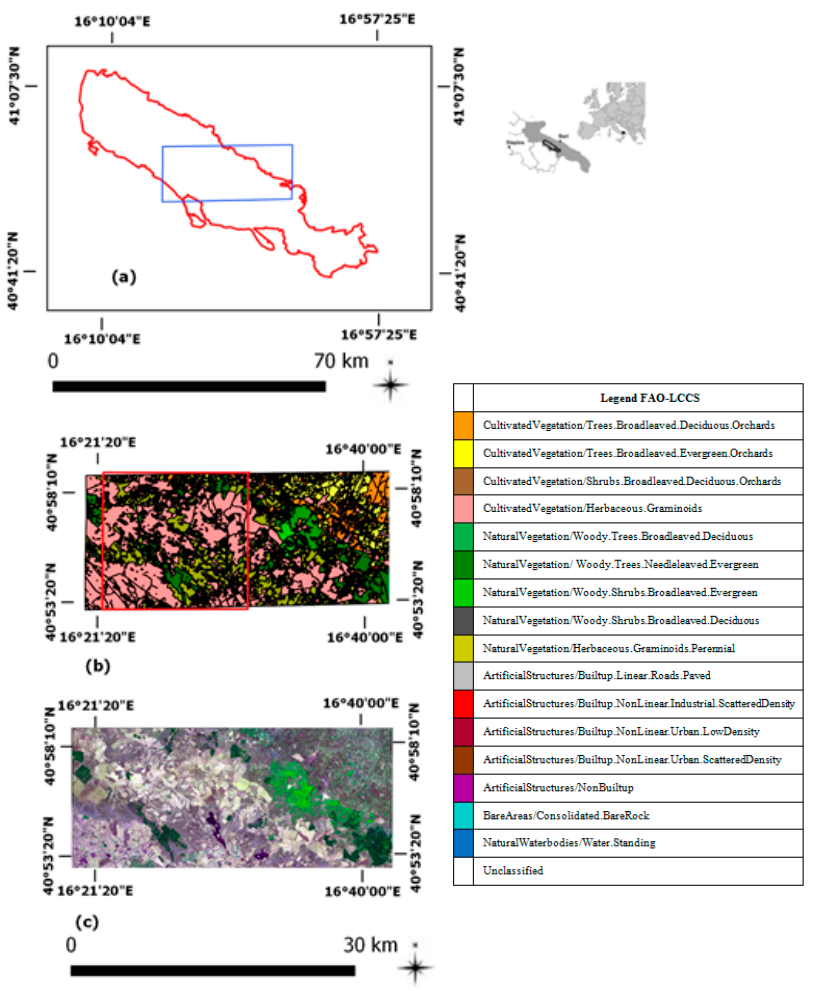
Figure 1. “Murgia Alta” Natura 2000 site: ( a ) the red line is the study site location and extension of “Murgia Alta” National Park and the blue line is the analysed area; ( b ) existing LC map dated 2006; and ( c ) available Worldview-2 input image (17,000 × 7000 pixels wide), 2 m resolution, 6 July 2012. False Colour Composite: R = 5, G = 7, B = 2.